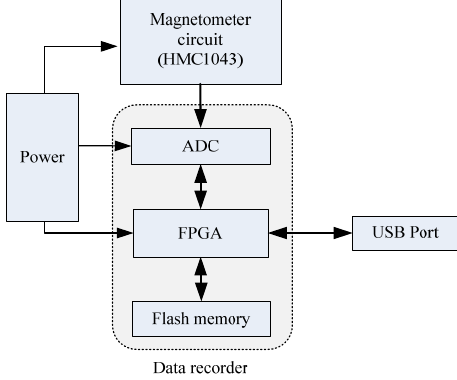
Figure 19. Hardware components diagram of the AMU.